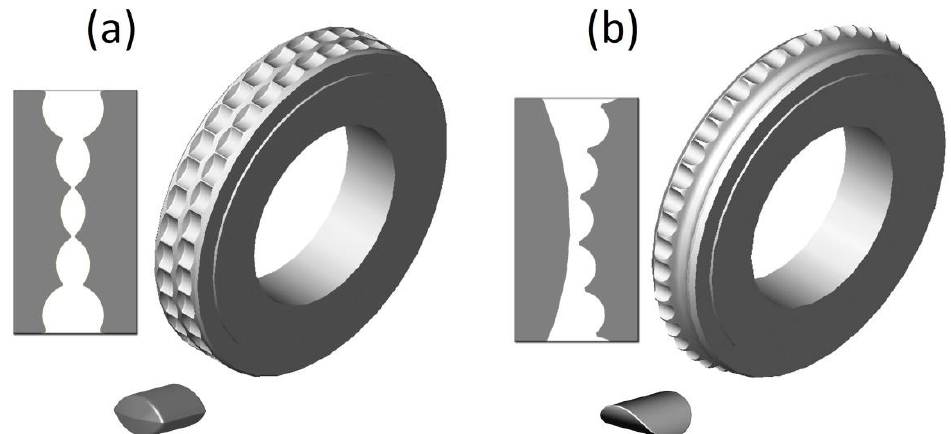
Figure 1. The view of the roller press forming rollers with a working surface to produce briquettes ( a ) in the shape of a pillow and ( b ) in the shape of a saddle.